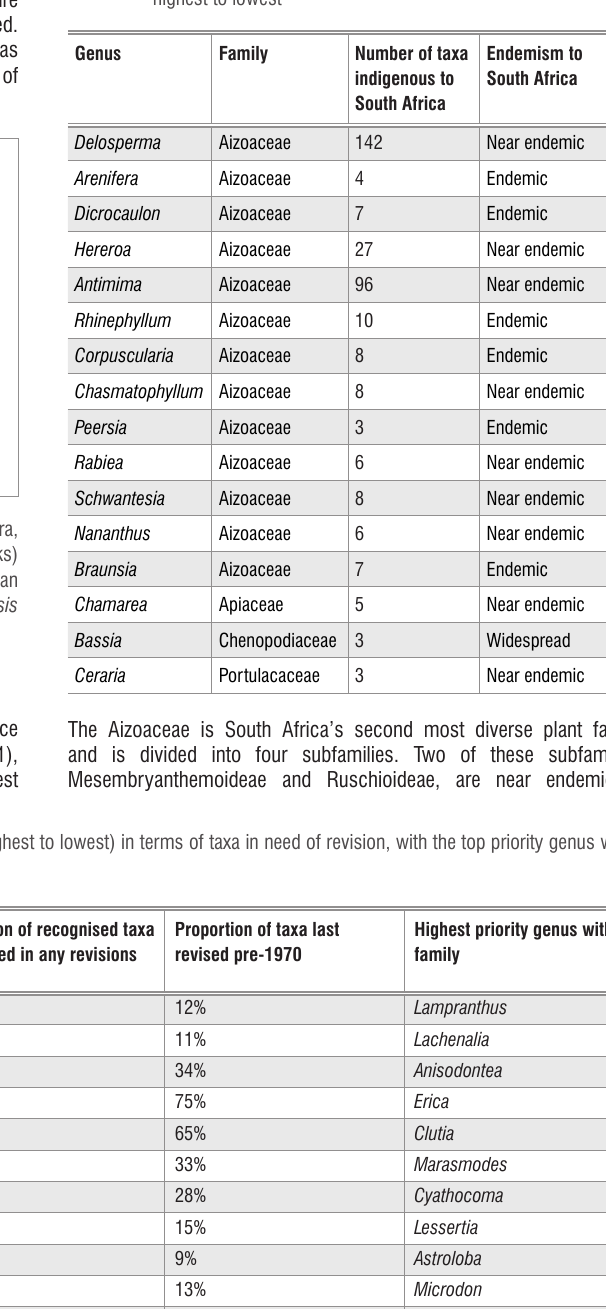
Table 2: South African plant genera which to date have had no taxonomic